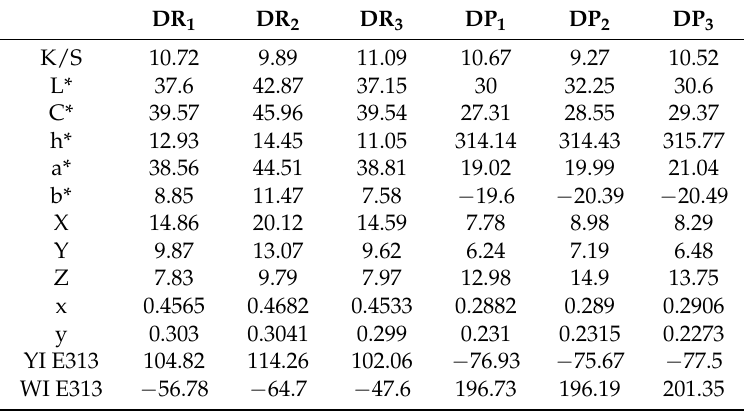
Table 2. Colorimetric data of the rubber colored with reactive disperse silicon-containing